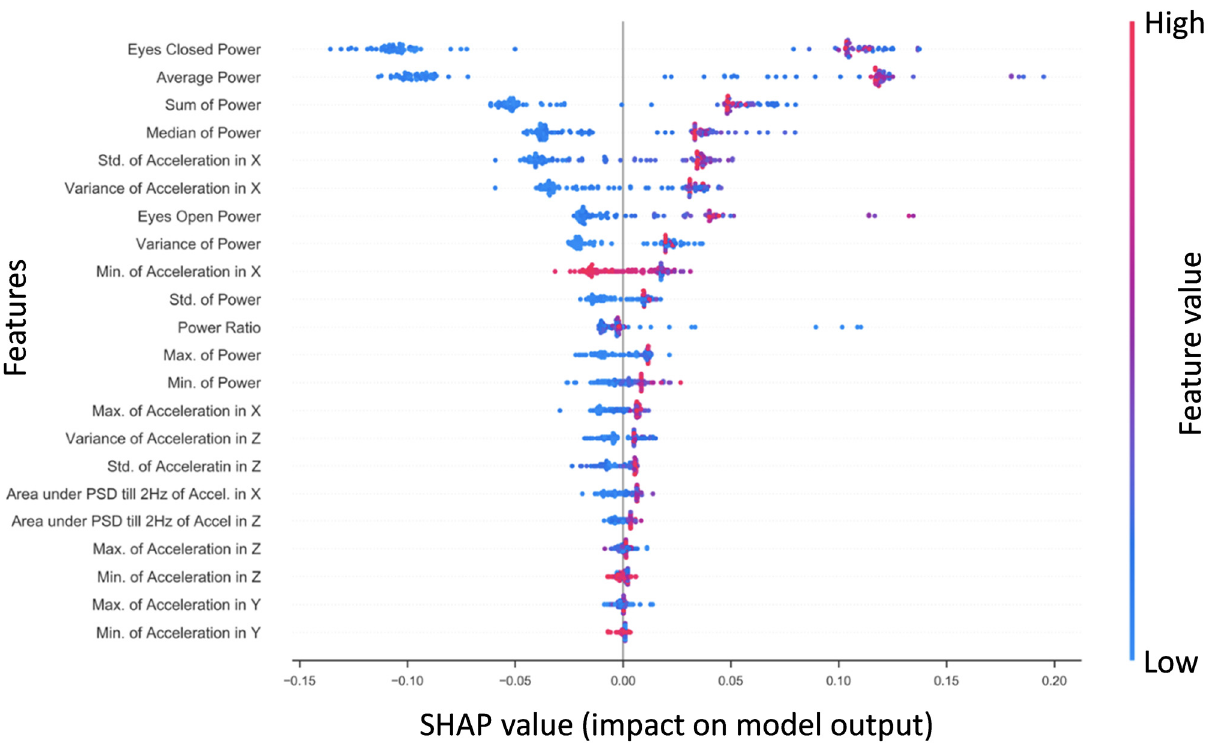
Figure 2. The Random Forest SHAP values for all patients in the training set ( n = 108). Features are ranked top to bottom (top being the largest contributor). A single point represents a patient‘s SHAP value for a given feature. Along the x -axis, a positive (negative) SHAP value indicates the features’ impact toward classifying a patient as concussed (healthy control). Color indicates the actual value of a subject’s feature value.